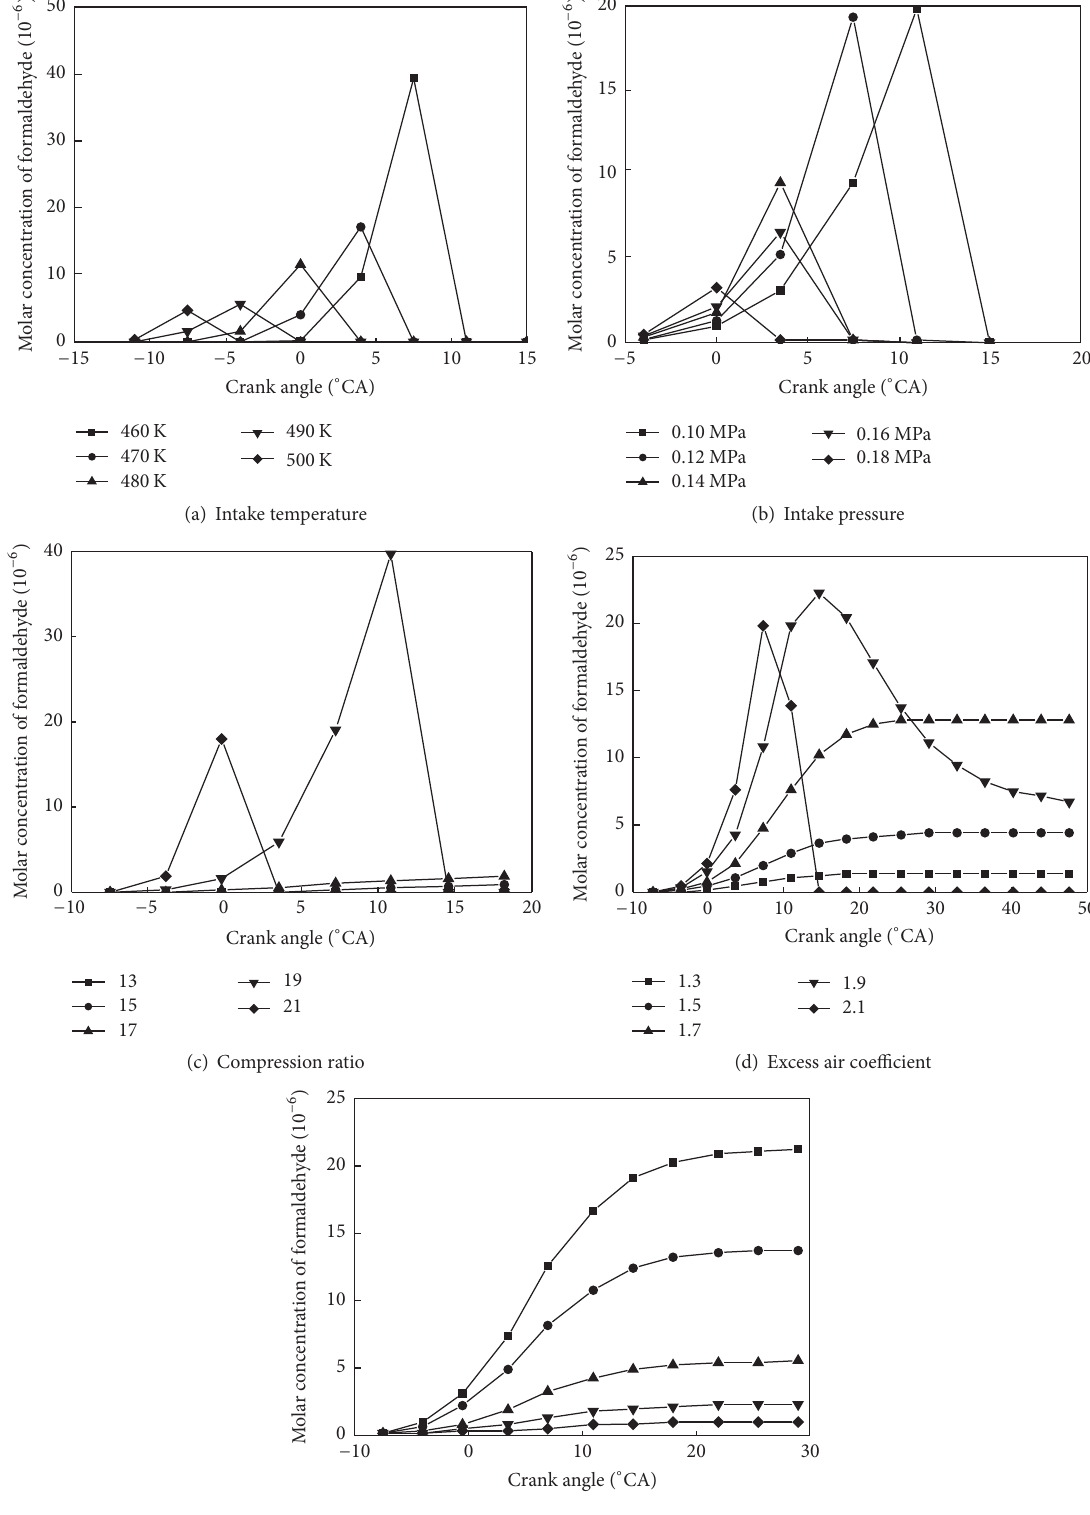
Figure 5: Influence of temperature, pressure, compression ratio, excess air coefficient, and EGR ratio on formaldehyde